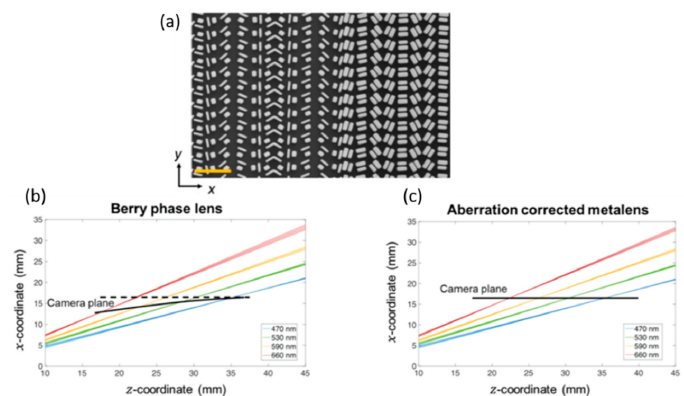
Figure 16. Compact aberration-corrected spectrometer. ( a ) Scanning electron micrographs of a fabricated aberration-corrected off-axis metalens. ( b ) A regular Berry-phase lens and ( c ) an aberration-corrected metalens. The metalenses designed with focal length 𝑓 = 40 mm and focusing angle 𝑎 = 25 degrees at wavelength 𝜆 = 470 nm. The focusing planes for each case are indicated by bold lines; the dashed line in the left is horizontal and meant as a reference to the curved focal plane. (Reproduced from [107] with permission.)